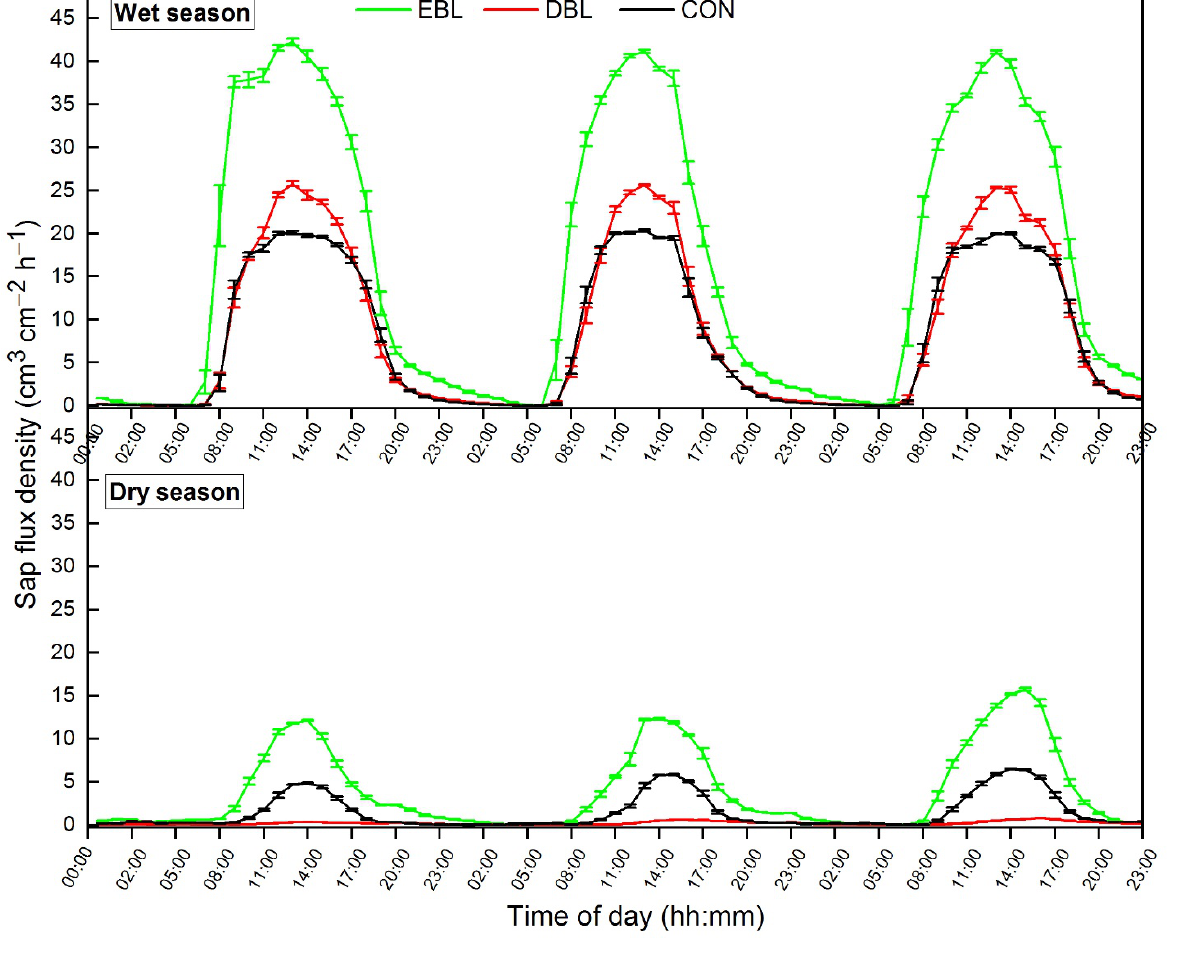
Figure 4. Diurnal patterns of mean sap flux densities (Mean ± SE) of selected evergreen broad-leaved trees (EBL), deciduous broad-leaved trees (DBL), and conifers (CON) during the dry (25 July 2017 to 27 July 2017) and wet (17 January 2018 to 19 January 2018) season on sunny days. Bars are ± SE.